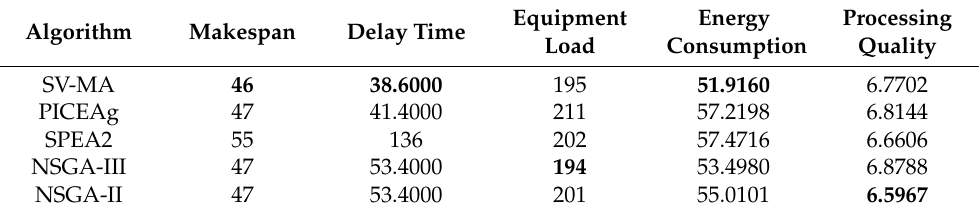
Table 7. The best compromise